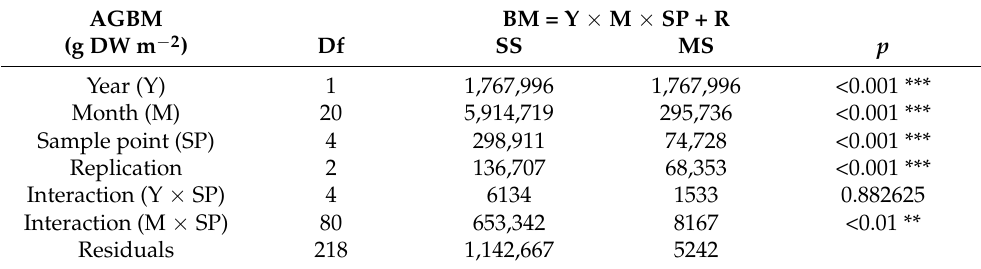
Table 3. Analysis of variance for aboveground green grass biomass (AGBM). ***, **: significant at p -value ≤ 0.001, ≤ 0.01, respectively. Abbreviations: Df: degree of freedom; SS: sum of square; MS: mean square.